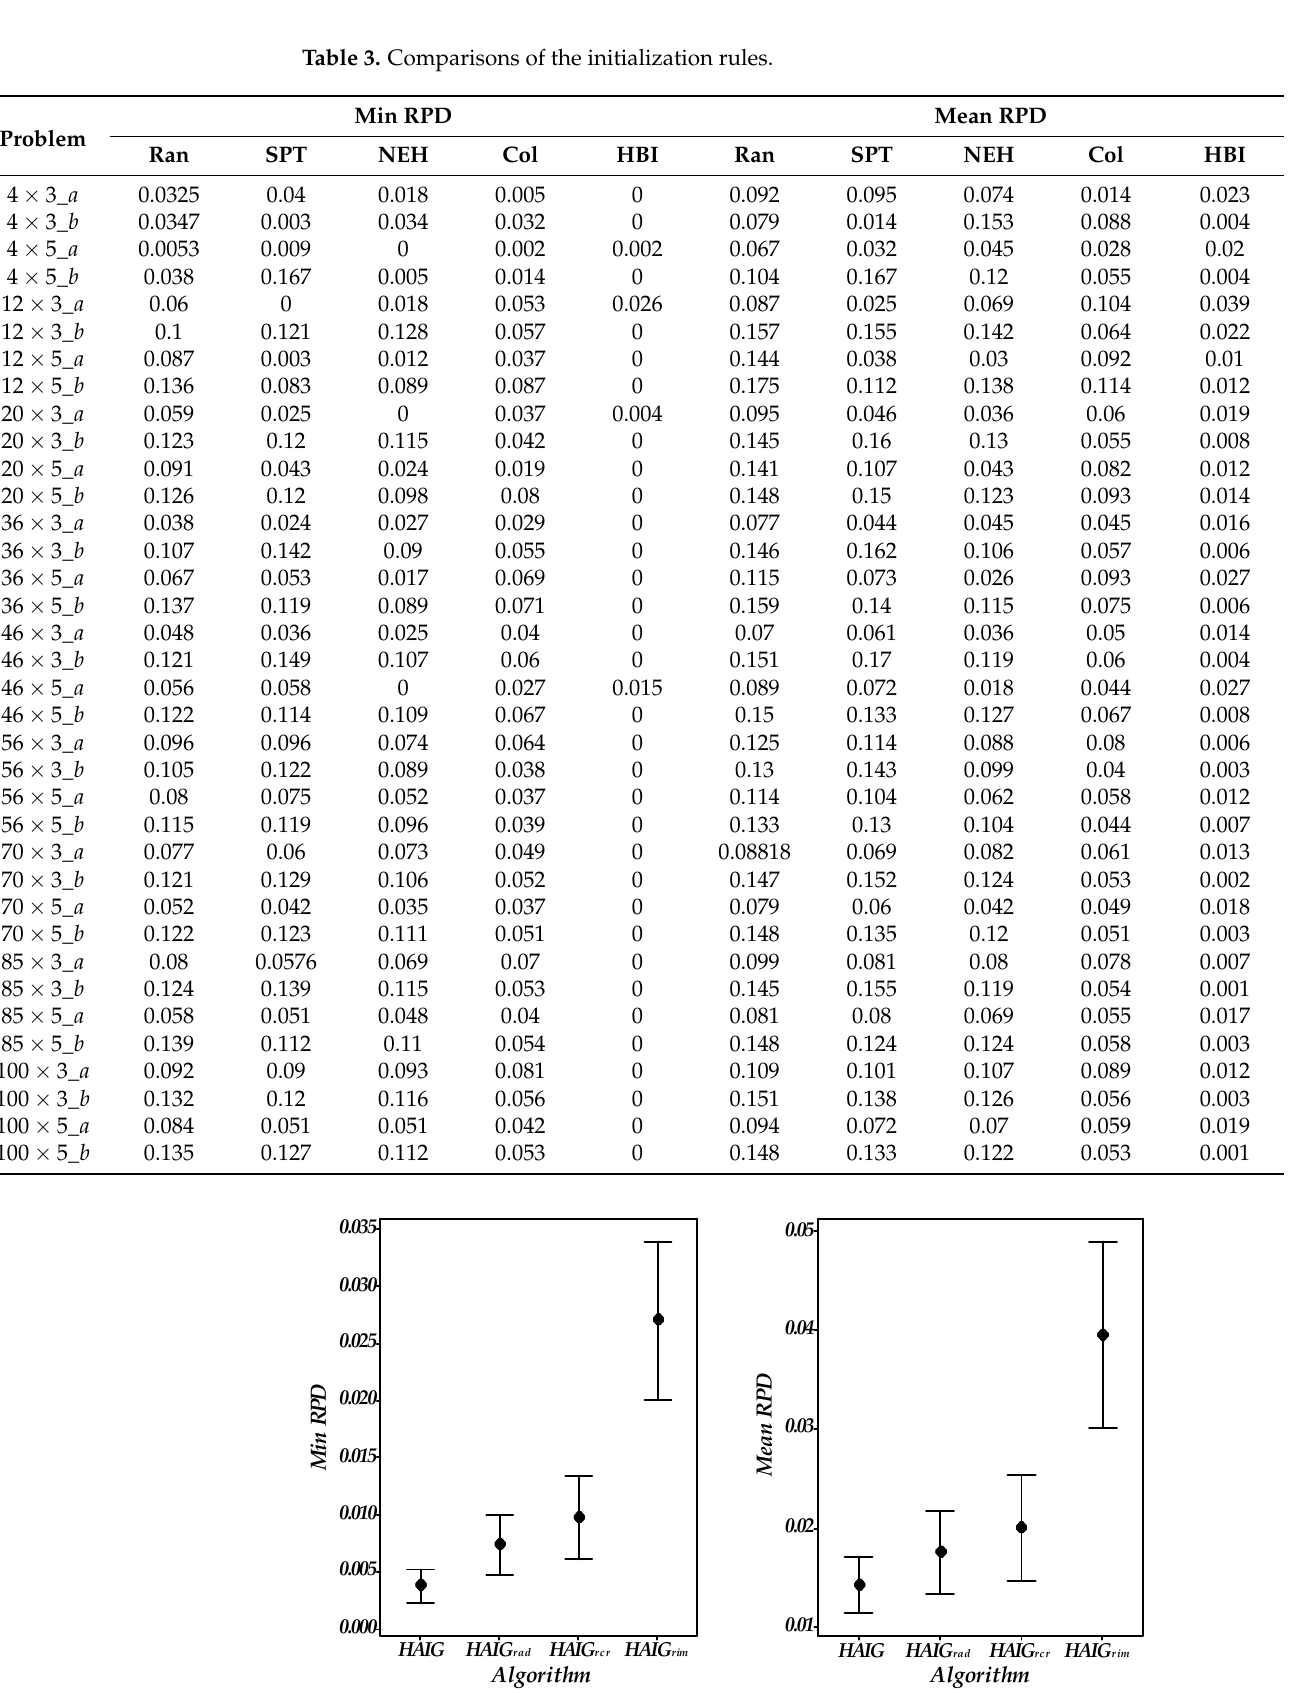
, HAIG HAIG and HAIG algorithms. Figure 7. Comparisons of HAIG rcr , HAIG rad, HAIG rim and HAIG (cid:2928)(cid:2913)(cid:2928) (cid:2928)(cid:2911)(cid:2914), (cid:2928)(cid:2919)(cid:2923)